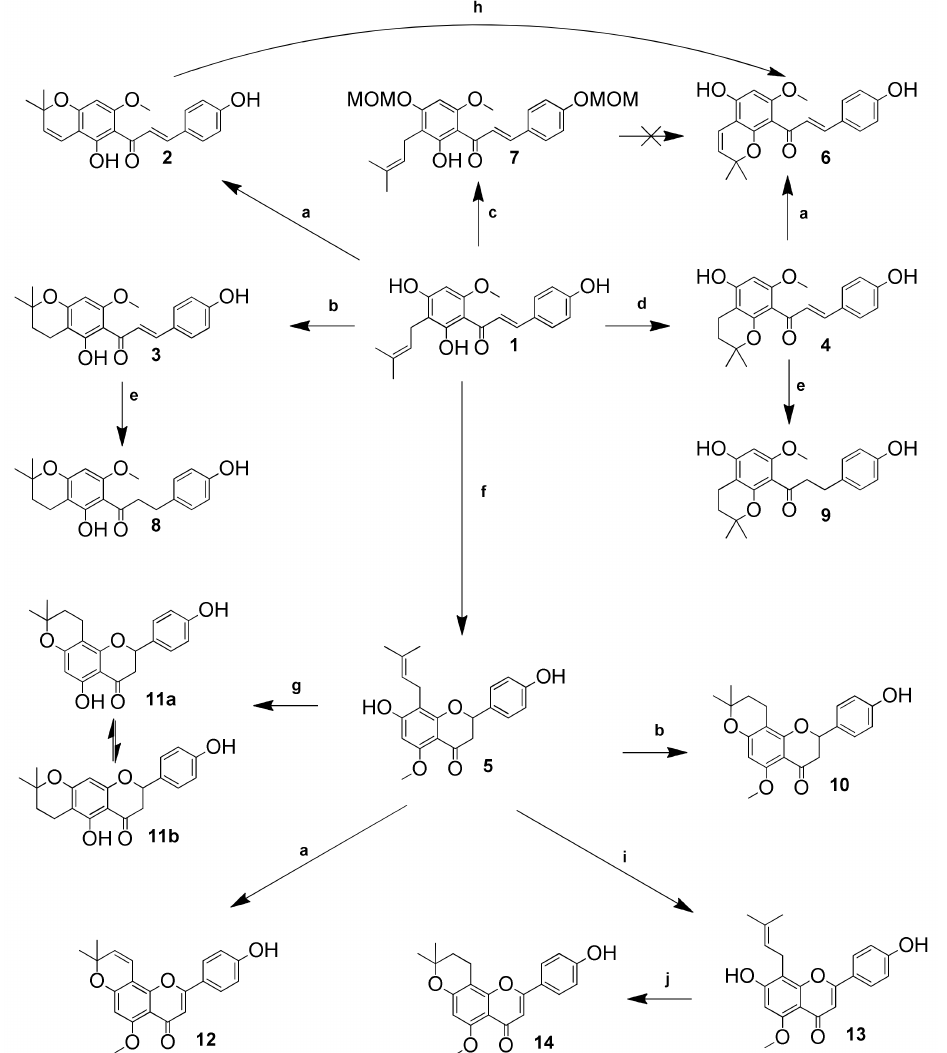
Scheme 1. General synthesis scheme of xanthohumol derived compounds. Reagents and